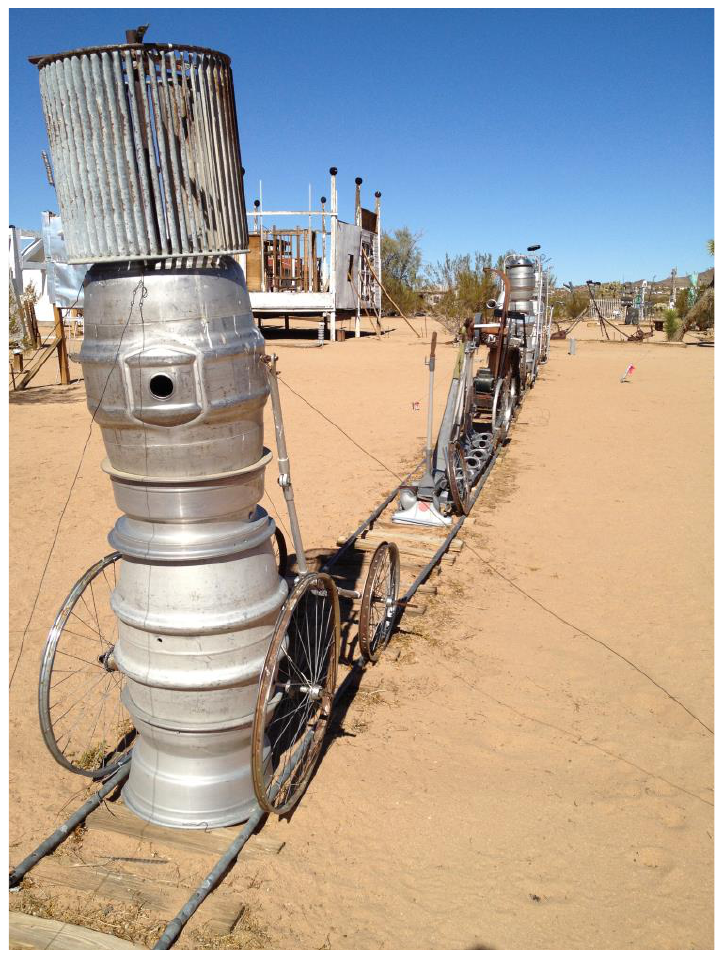
Figure 1. Noah Purifoy’s The Kirby Express , 1994 – 96. Outdoor Desert Art Museum of Assemblage Sculpture, Joshua Tree. Image courtesy of Noah Purifoy Foundation ©